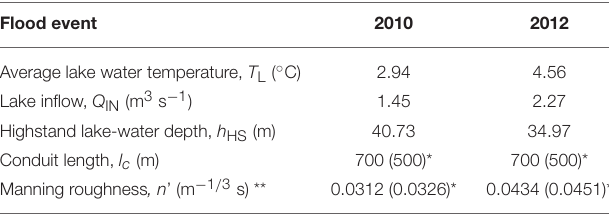
TABLE 3 | Parameters used in flood hydrograph